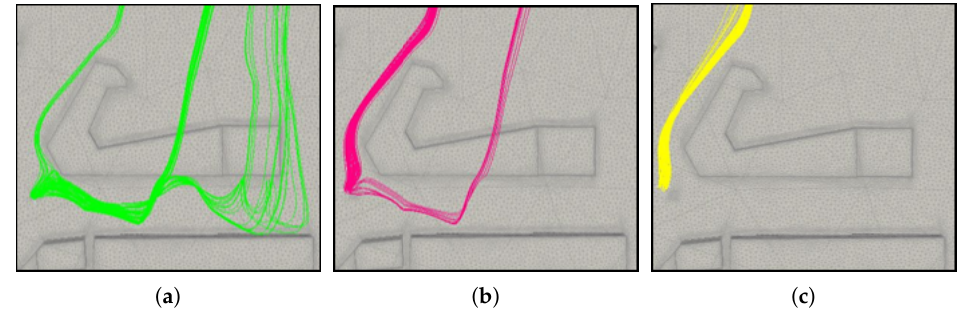
Figure 7. Mean streamlines from the source area: ( a ) the location in the wind tunnel denoted by ( X s , Y s ) , such that ( X , Y ) = ( X s , Y s ) ; ( b ) the location is shifted by 10 mm ( X , Y ) = ( X s , Y s + 0.01 m); ( c ) the location is shifted by 20 mm ( X , Y ) = ( X s , Y s + 0.02 m). The height, Z = 2.5mm, is the same for each case.